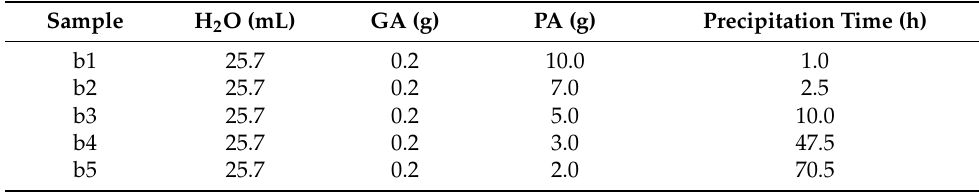
Table 2. Flocculent precipitation schedule.